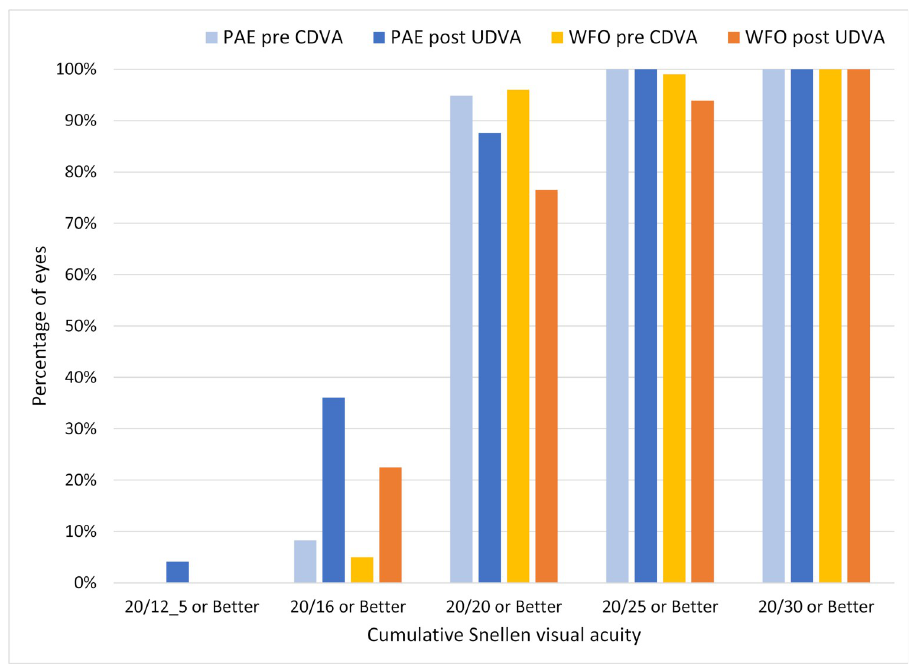
Fig 1. Preoperative corrected distance visual acuity (CDVA) and postoperative uncorrected distance visual acuity (UDVA) by treatment. Abbreviations: WFO–wavefront optimized, PAE–Phorcides Analytic Engine.